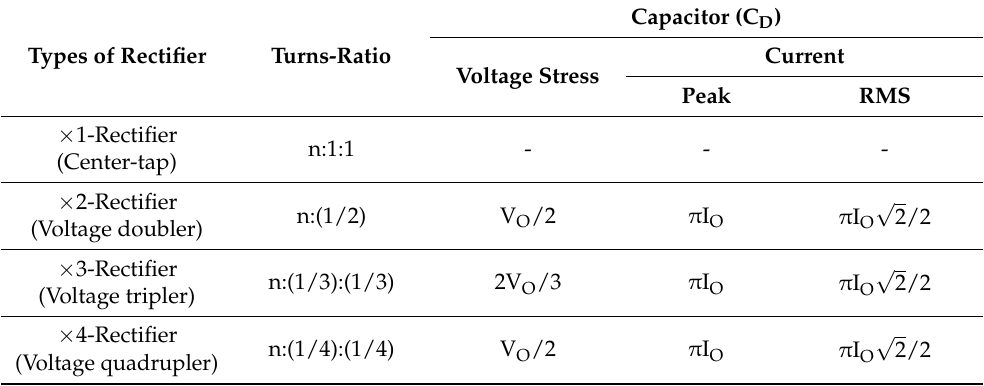
Table 3. Comparison of conventional and proposed rectifiers in secondary diodes (D S1 and D S2 ).